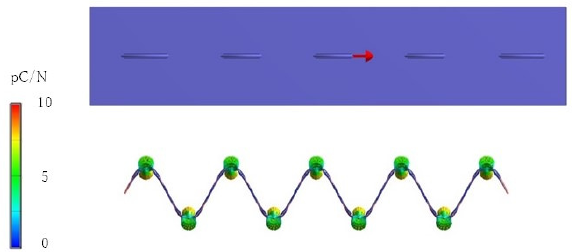
Figure 5. FEM calculation of piezoelectric response of a single piezoelectric PLLA braided cord sewn into the fabric under applied strain to the fabric (upper figure: top view, lower figure: cross-sectional view).